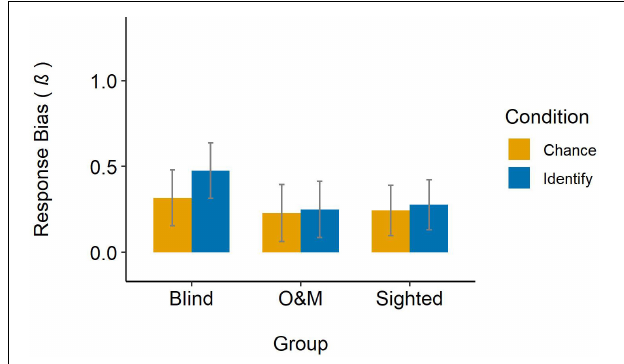
FIGURE 3 | Judges’ response bias across groups and conditions. Error bars represent 95% confidence intervals.